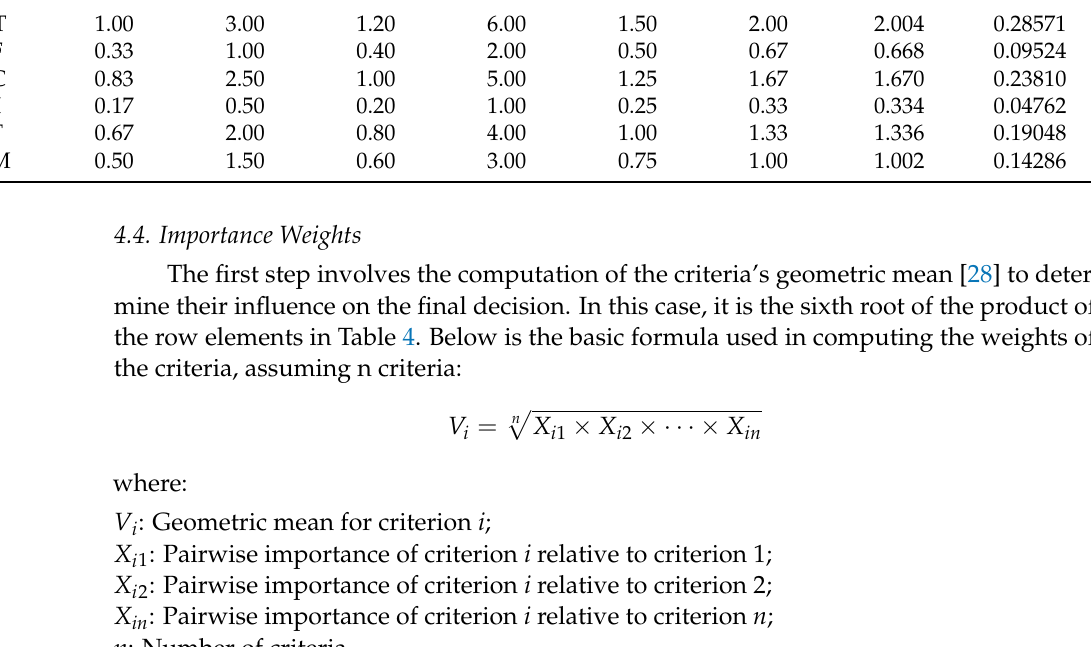
EST Esteem COM Communication